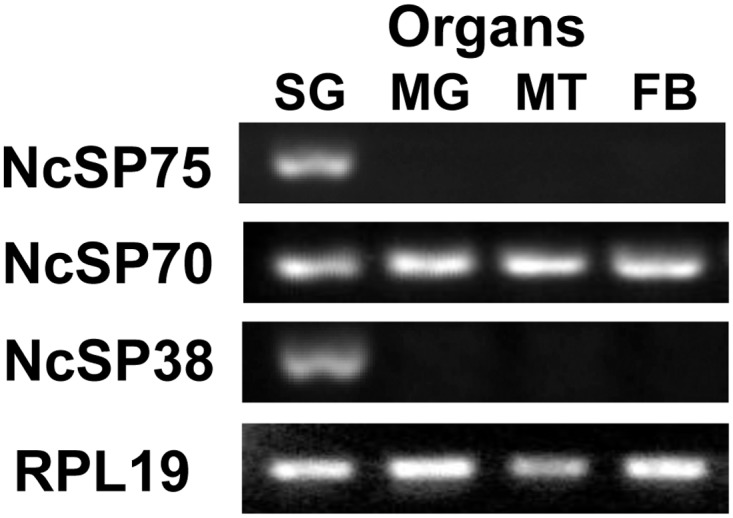
Expression of NcSP75, NcSP70, NcSP38 genes in different organs.RT-PCR on total RNA isolated from salivary glands (SG), midgut (MG), Malpighian tubules (MT), and fat bodies (FB) of adult females. Each gene was amplified with gene-specific primers. Ribosomal protein L19 primers were used as control in equal template amounts.